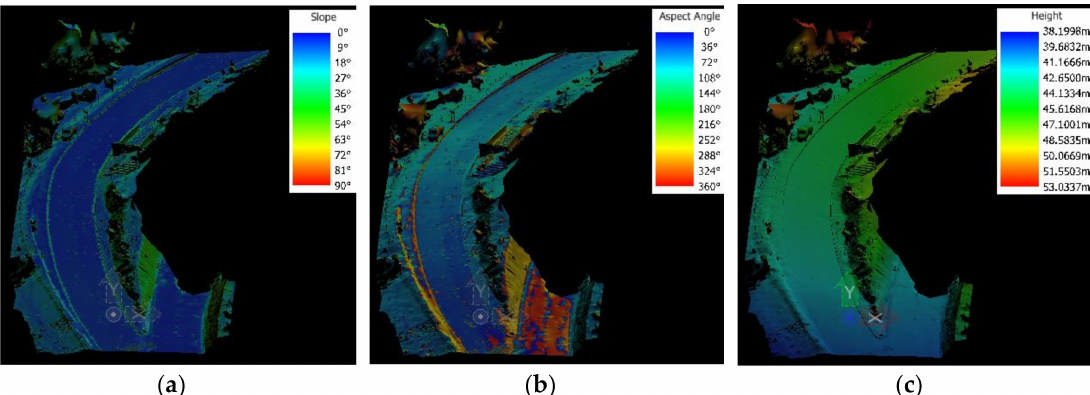
Figure 10. Display styles applied to model “MIRADOR1”: ( a ) Road slope; ( b ) UAV angle relative to the model surface; and ( c ) Road